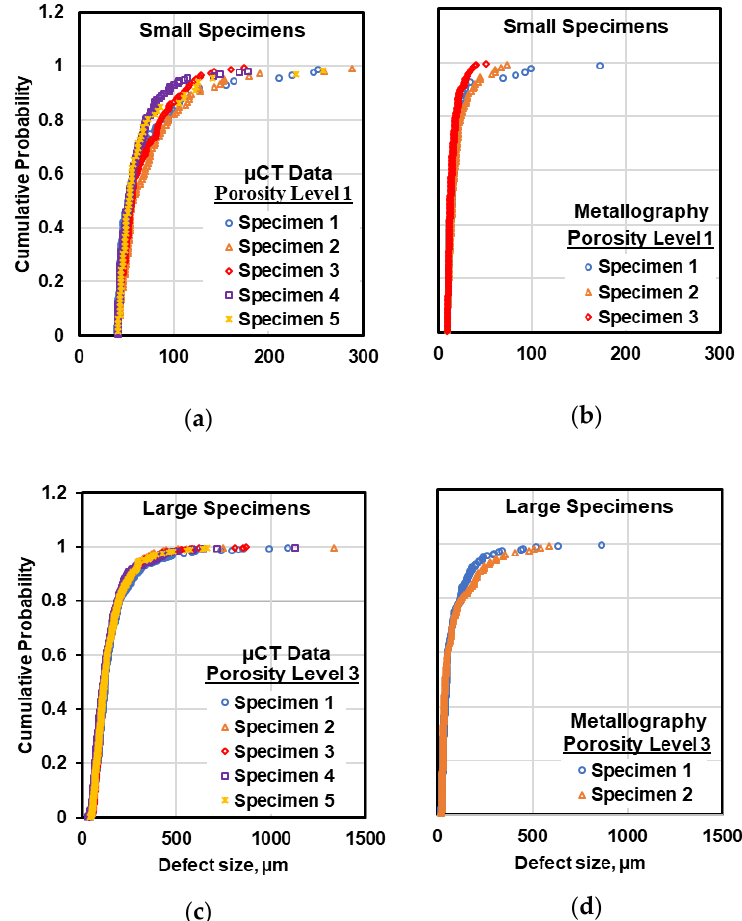
Figure 7. Examples of the defect distribution in different specimens of the size and porosity level using ( a , c ) µCT data and ( b , d ) metallography data.